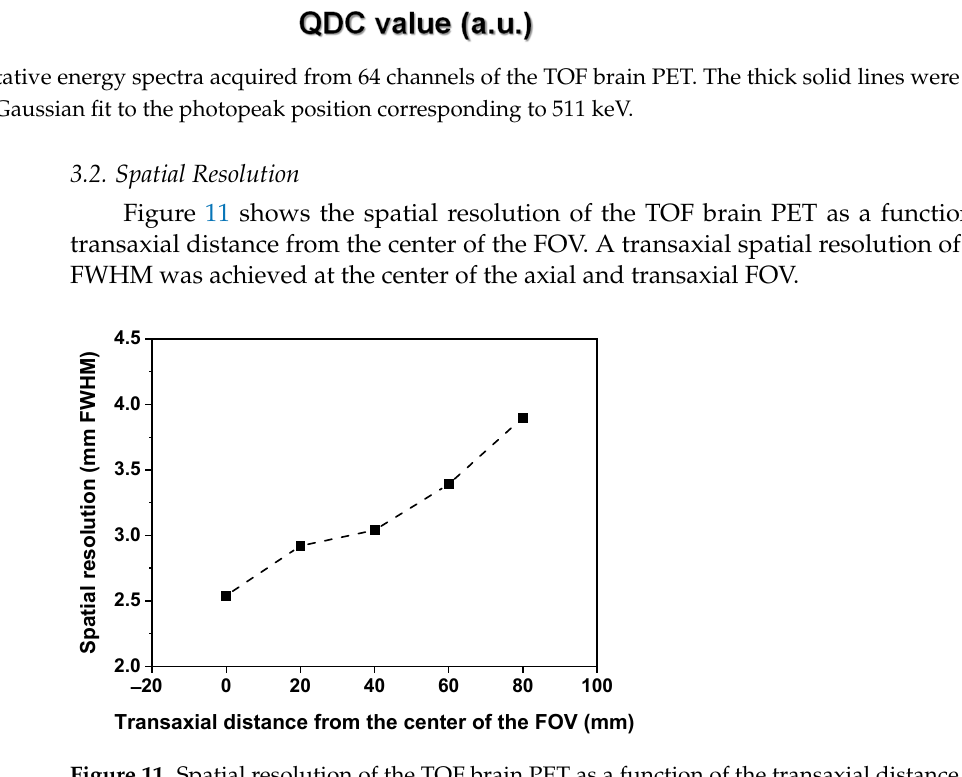
Figure 11. Spatial resolution of the TOF brain PET as a function of the transaxial distance from the center of the FOV.